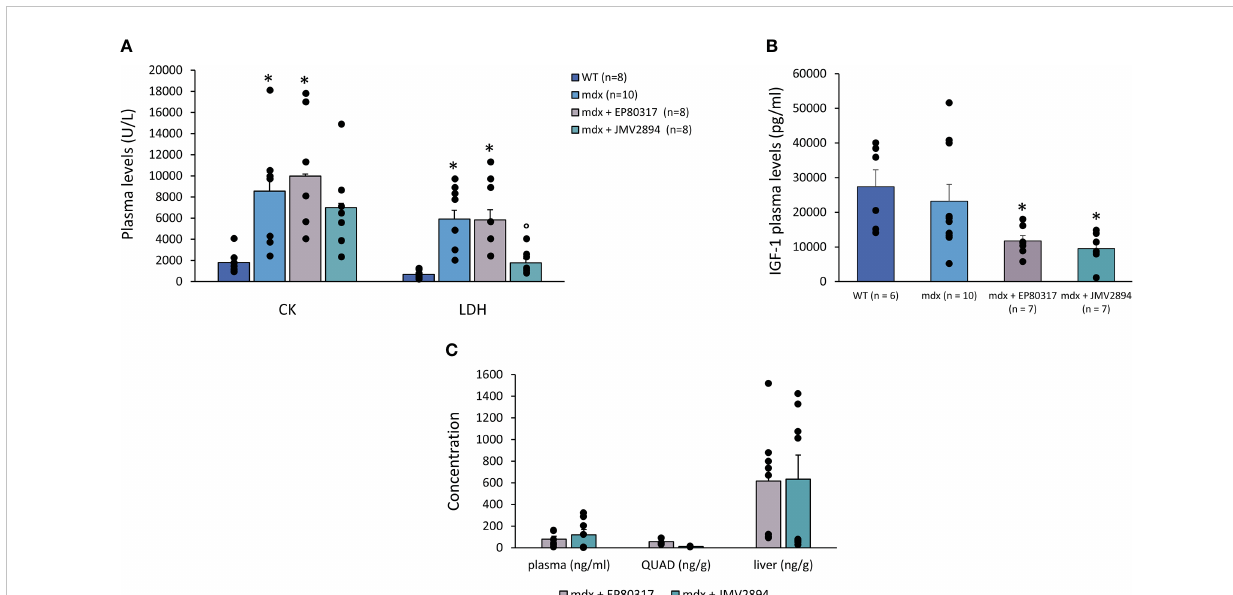
FIGURE 7 In (A) are shown the levels of enzymes creatine kinase (CK) and lactate dehydrogenase (LDH) (U/L), measured in plasma samples collected from mice of each experimental group. Values are expressed as mean ± SEM from the number (n) of mice indicated in brackets. A statistically signi fi cant difference among groups was found by one-way ANOVA for both CK (F = 6.4, p = 0.002) and LDH (F = 13.4, p = 8.10*10 -6 ). Bonferroni post hoc test for individual differences between groups is as follows, CK: * vs. WT (0.0003 < p < 0.01); LDH: * vs WT (4.23*10 -5 < p < 1.6*10 -5 ), ° vs mdx (0.0002 < p < 0.0004). In (B) are shown the levels of IGF-1 measured in plasma samples collected from mice of each experimental group (pg/ml). A statistically signi fi cant difference among groups was found by one-way ANOVA (F = 5.9, p = 0.004). Bonferroni post hoc test for